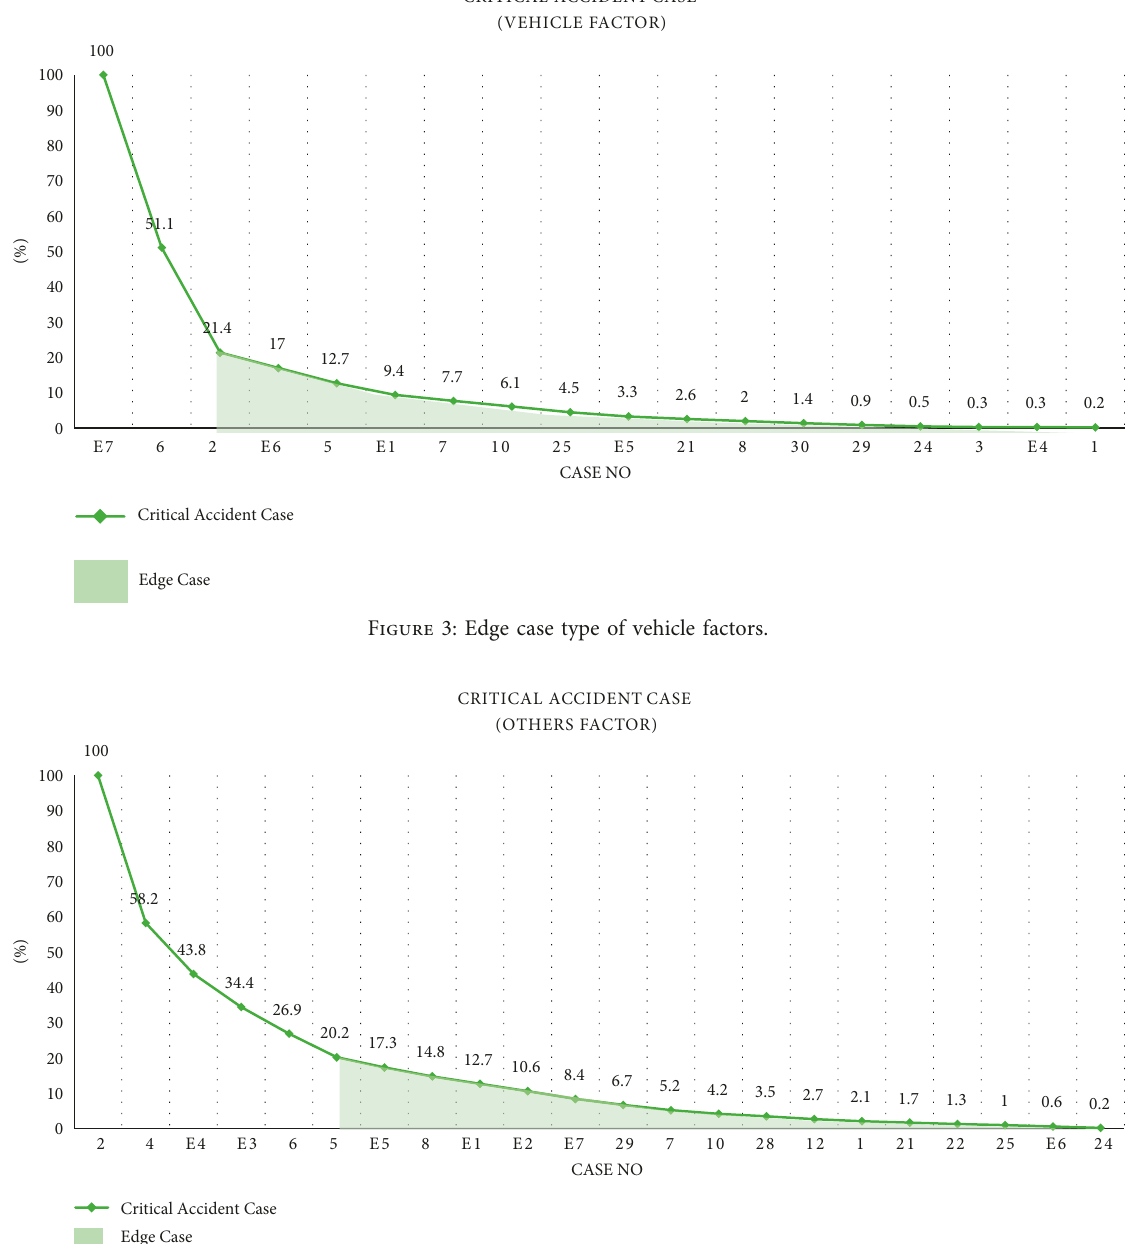
Figure 4: Edge case type of other